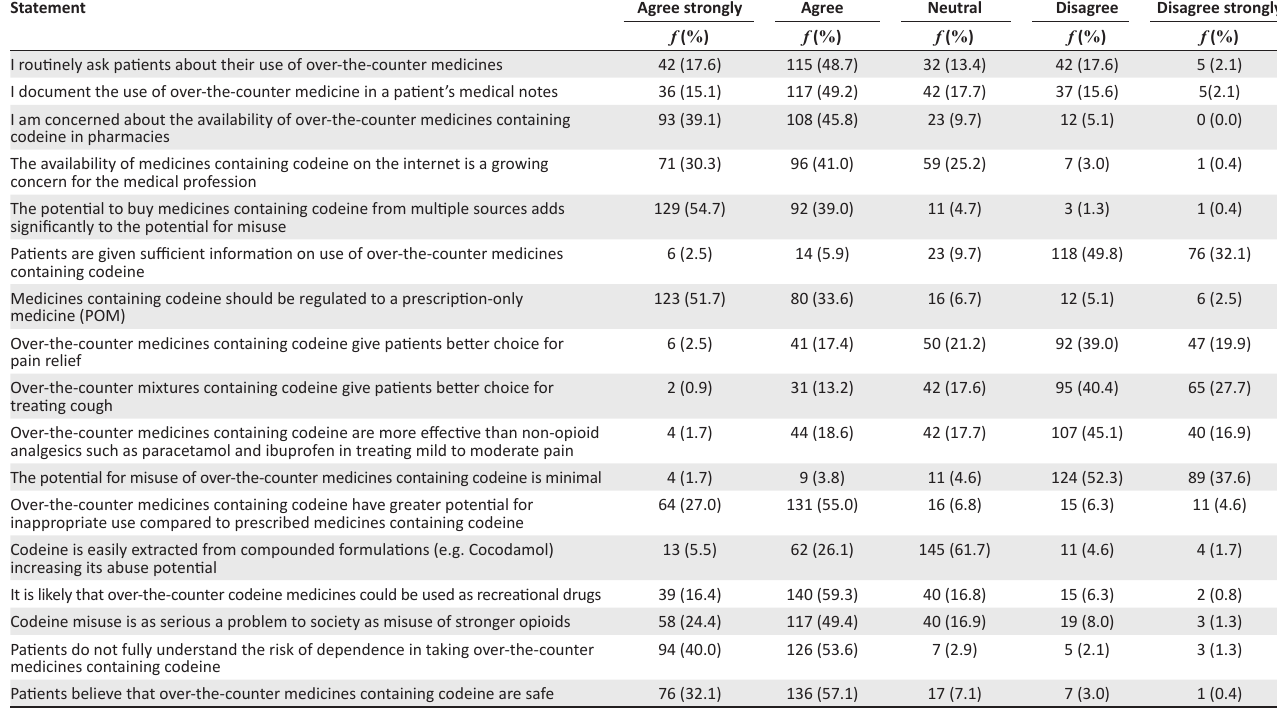
TABLE 3: Level of agreement, disagreement and neutral responses with each of the statements related to over-the-counter codeine.